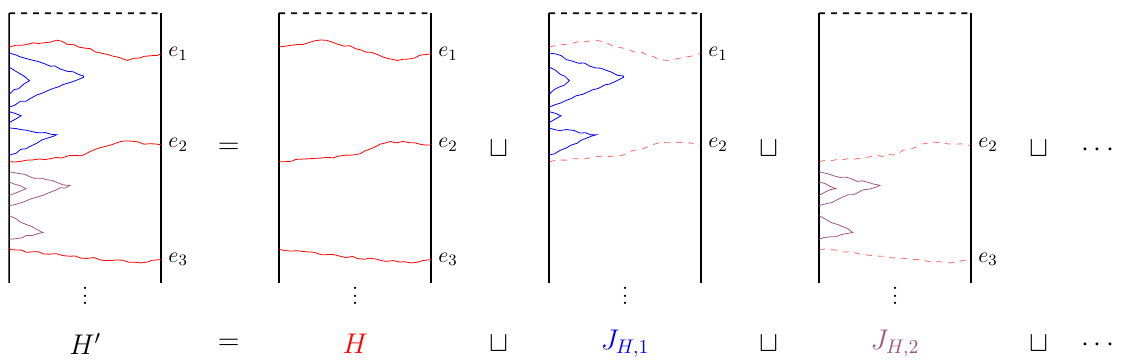
FIG. 6. The outline of the main idea of the proof of Theorem 10. We choose a domain-wall trajectory H that has k domain walls that never annihilate and such that the distance between consecutive domain walls is always at most n H . We then choose domain-wall trajectories J H ,1 , . . . , J H , k such that the domain walls of J H , j lie between the j th and ( j + 1 ) th domain walls of H and all annihilate before the end of the circuit. The domain-wall configuration H (cid:12) is the disjoint union of H and J H , j for j = 1, . . . , k . We can